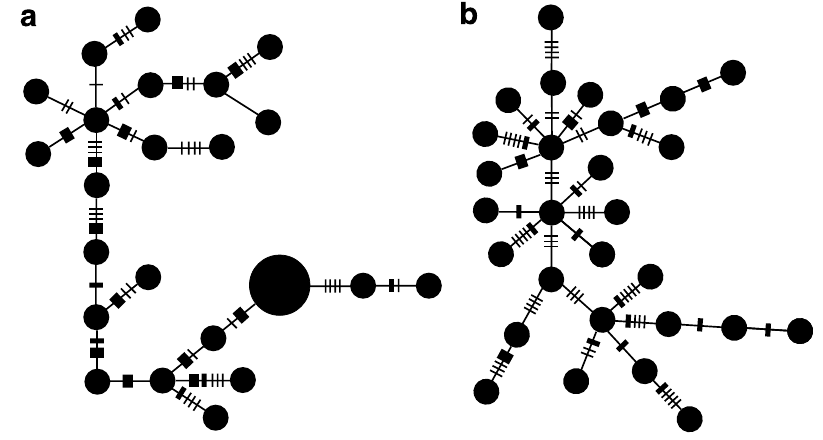
Figure 2. Minimum spanning tree for haplotypes of widespread species a) Centropyge bispinosa (n = 24), and b) C. flavicauda (n = 28) collected from Christmas Island. The size of the circle indicates the relative abundance of each haplotype (smallest circle = 1 individual, largest circle = 2 individuals). Bars indicate the number of substitutions between haplotypes, with thin bars = 1 substitution, medium bars = 5 substitutions, and thick bars = 10